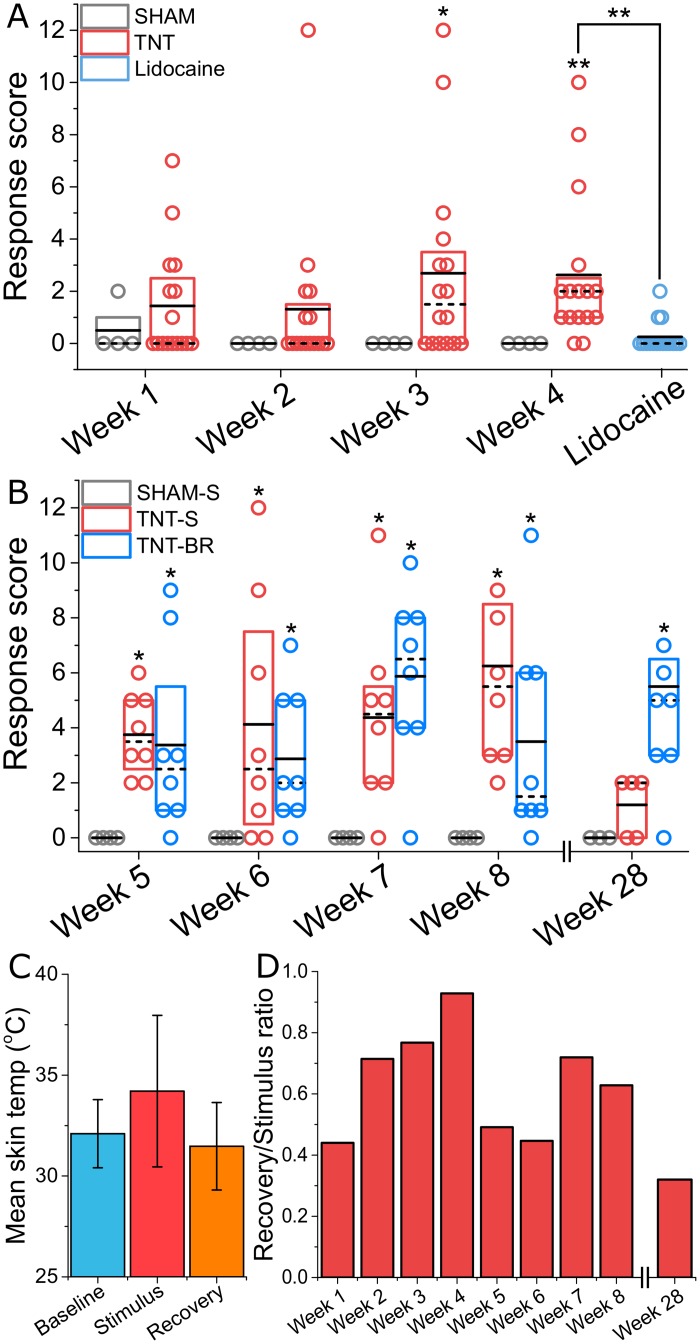
Radio-frequency electromagnetic field (RF EMF) stimulation elicits post-neurotomy pain.(A) Hollow circles indicate the summed response score for each animal for both TNT (red) and SHAM (grey) groups. Only one behavioral pain response was observed in the SHAM group over all 10 experimental trials. Statistically significant mean response scores (solid black line) were observed between TNT and SHAM groups beginning in week 2 and continuing through week 8. Lidocaine was found to be a successful moderator of RF EMF-induced neuroma pain. Dashed black lines indicate population median. (B) Following bulb resection surgery, significant RF EMF-induced neuroma pain persisted from week 5 until week 28. For statistical comparisons, a two-tailed Mann-Whitney test was used (* p<0.05, ** p<0.01). (C) RF EMF exposure induces mean skin temperature increase. A mean skin temperature increase of 2.2°C was observed following 10 minutes of RF EMF exposure. (D) Recovery/Stimulus behavioral response ratios for all time points.